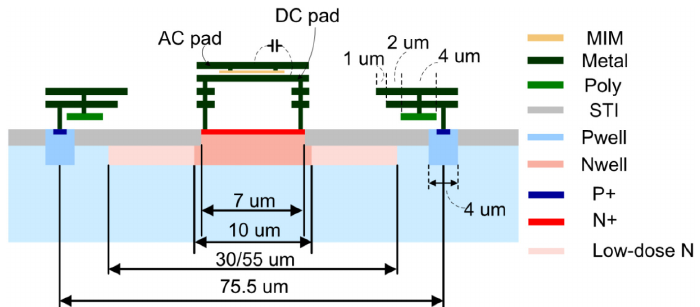
Figure 2. Schematic drawing of the low dose design implantation of the passive strip CMOS detector. MIM and STI stand for metal-insulator-metal and shallow trench isolation, respectively. Reprinted with permission from Ref. [10]. 2022,